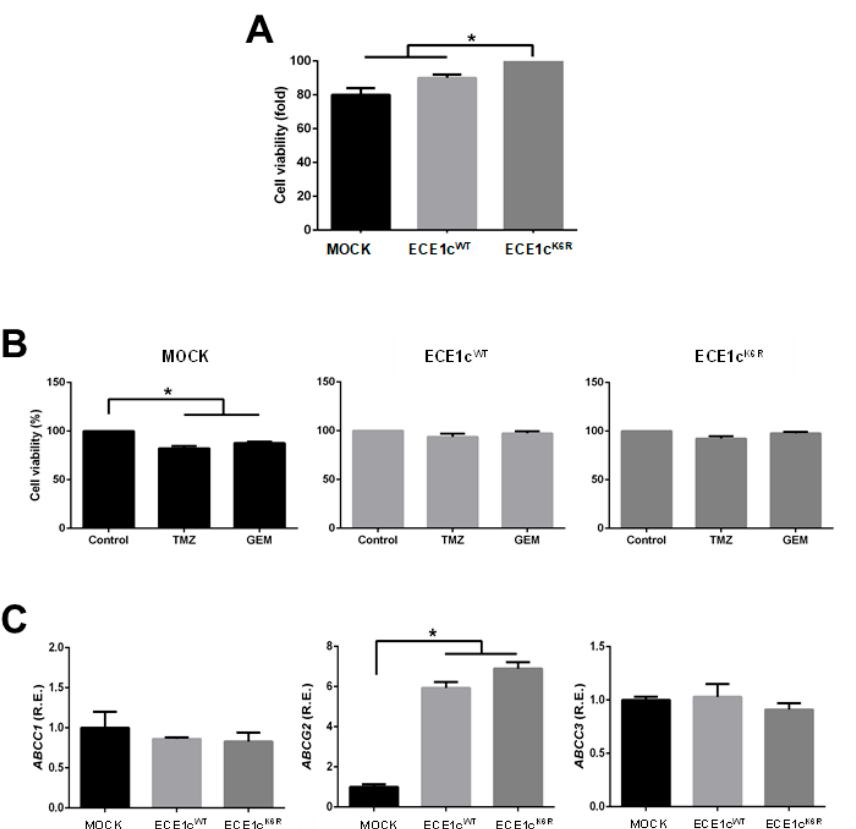
Figure 5. ECE1c overexpression conferred resistance to temozolomide and gemcitabine. ( A ) Basal viability of mock, ECE1c WT -expressing, and ECE1c K6R -expressing U87MG clone cells was measured after 24 h of growth in normal conditions using an MTS assay. ( B ) The chemoresistance of cells grown as in A was determined in the presence of either 400 µ M temozolomide (TMZ) or 4 µ M gemcitabine (GEM). DMSO was used as a vehicle (control). ( C ) Cells grown as in A under normal conditions were analyzed for the mRNA levels of the ABCC1, ABCG2, and ABCC3 genes using RT-qPCR. Data represent averages ± SEMs ( n = 3). Peritz F and Student’s tests were used. * p ≤ 0.05.